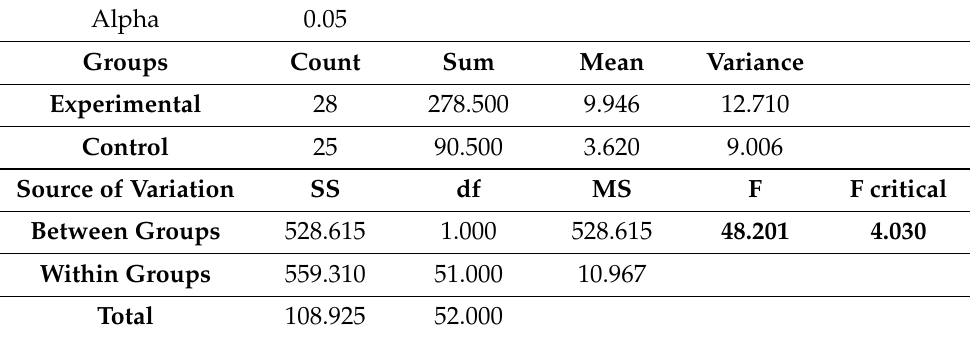
Figure 15. Comparison of average points gained per group ( left ) and quartile graphs for points gained ( right ). Table 5. ANOVA (single factor) results for overall achievement tests group